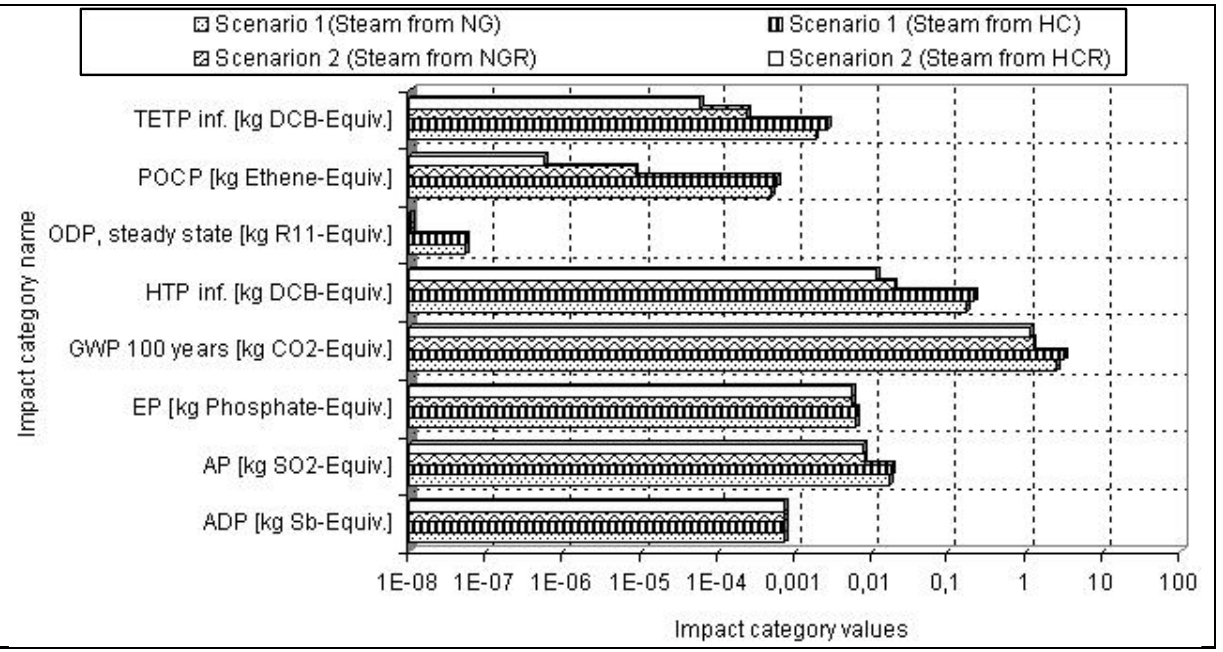
Figure 3. Impact assessment comparisons between